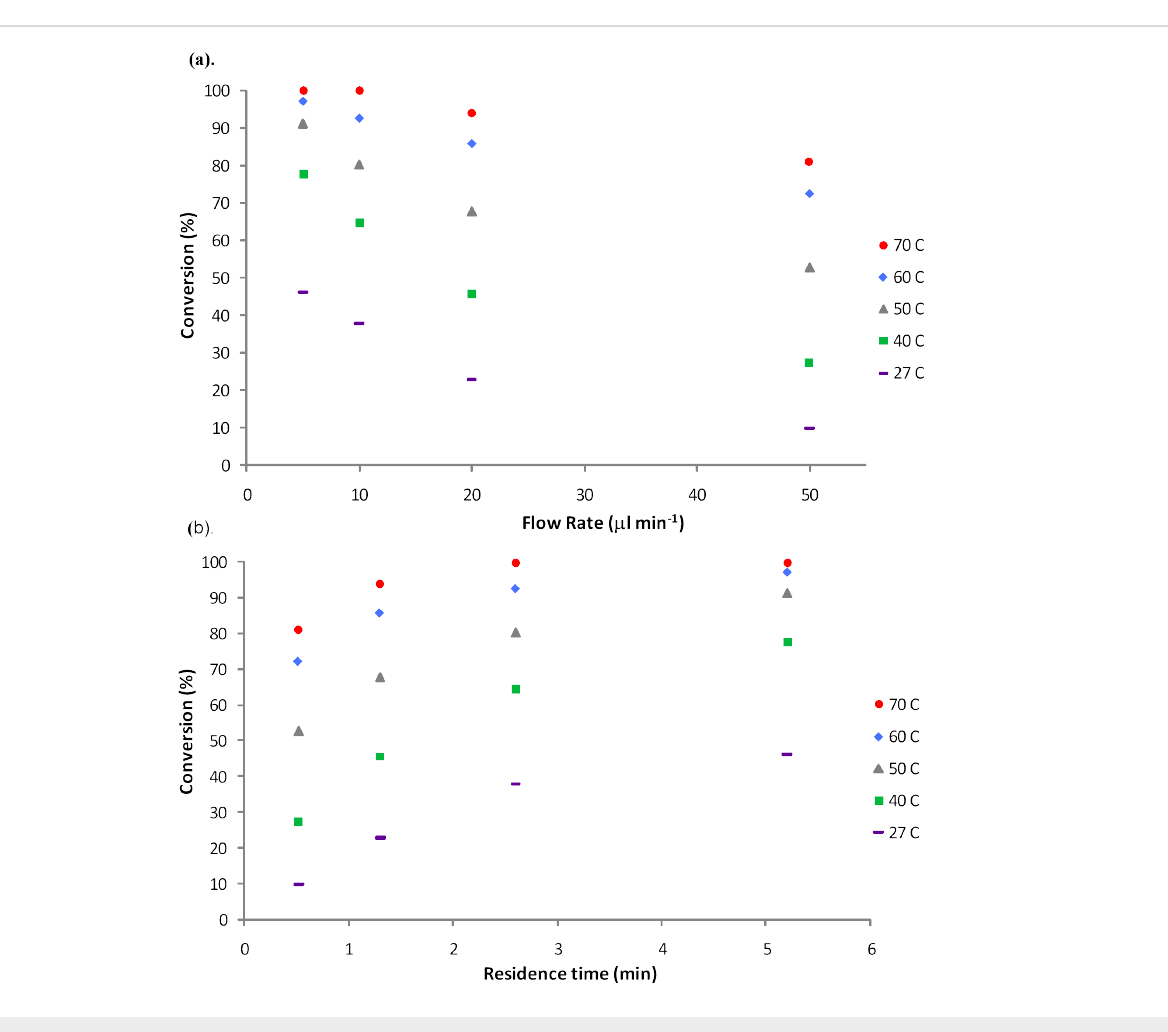
Figure 3: Graph illustrating the effect of (a) flow rate and (b) residence time on the conversion of 1-methylcyclohexene ( 6 ) to 1-methylcyclohexene oxide ( 7 ) at various reaction temperatures (27 to 70